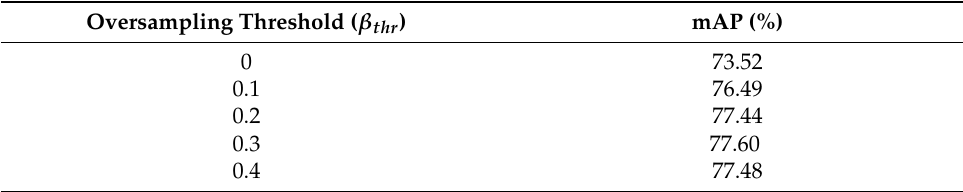
Table 8. Comparison of detection accuracy by varying the oversampling threshold β thr . The metric mAP was evaluated on the DOTA-v1.5 test set.